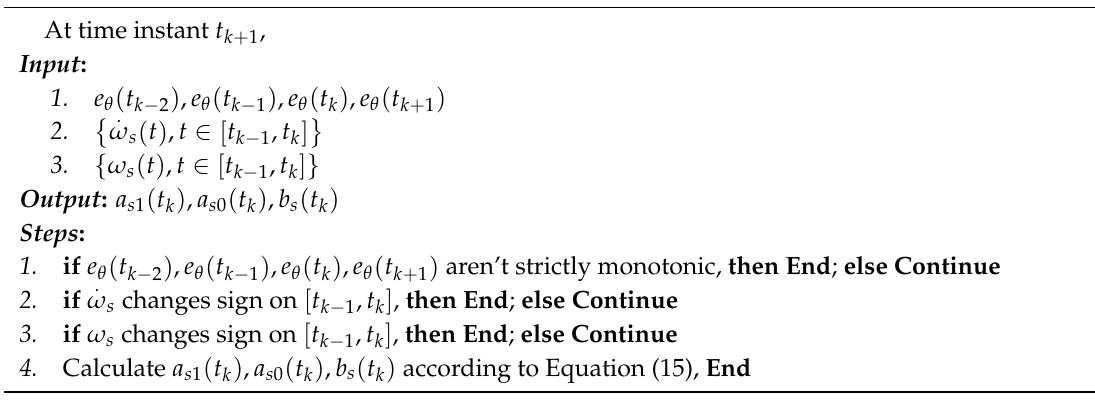
Algorithm 1 : One-step-delay adaptive learning